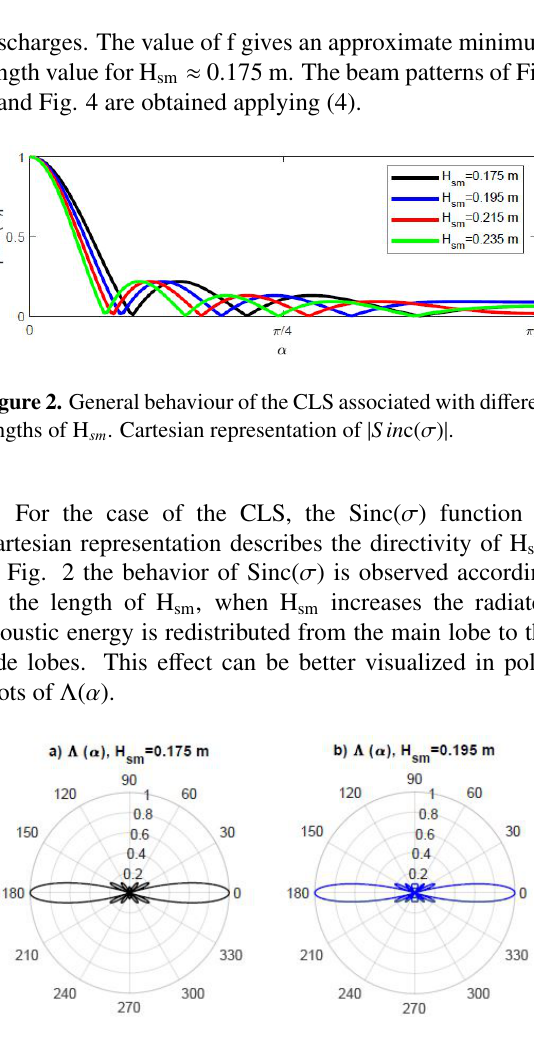
Figure 3. Polar plots of the beam patterns of the silo music phenomenon for a) H sm = 0.175 m and b) H sm = 0.195 m.